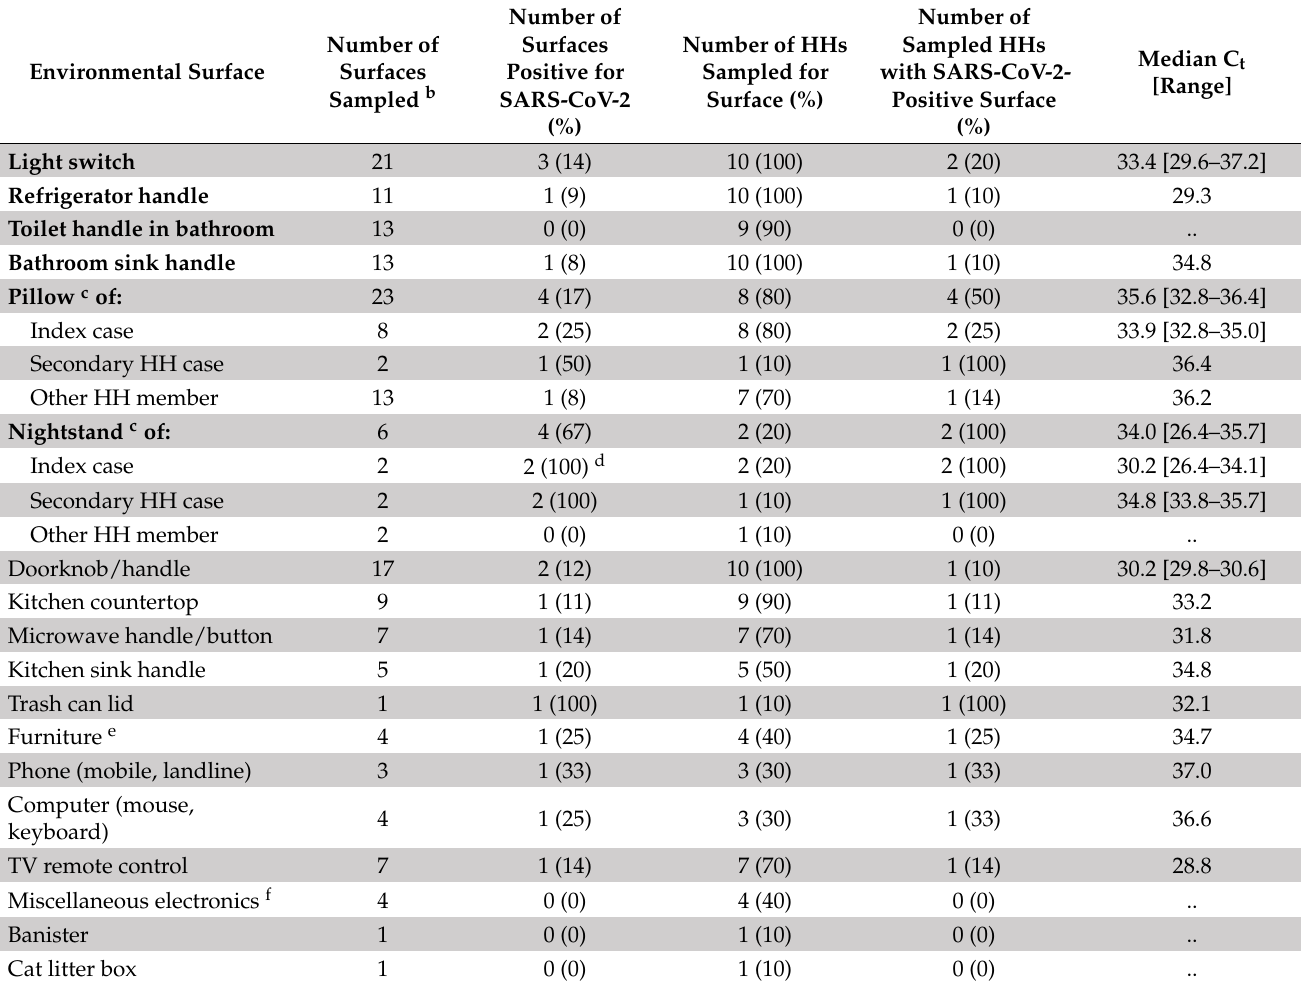
Table 2. Location and median cycle threshold (C t ) a value of SARS-CoV-2 detected at the environmental surfaces sampled across ten households (HHs) with ≥ 1 laboratory-confirmed case of